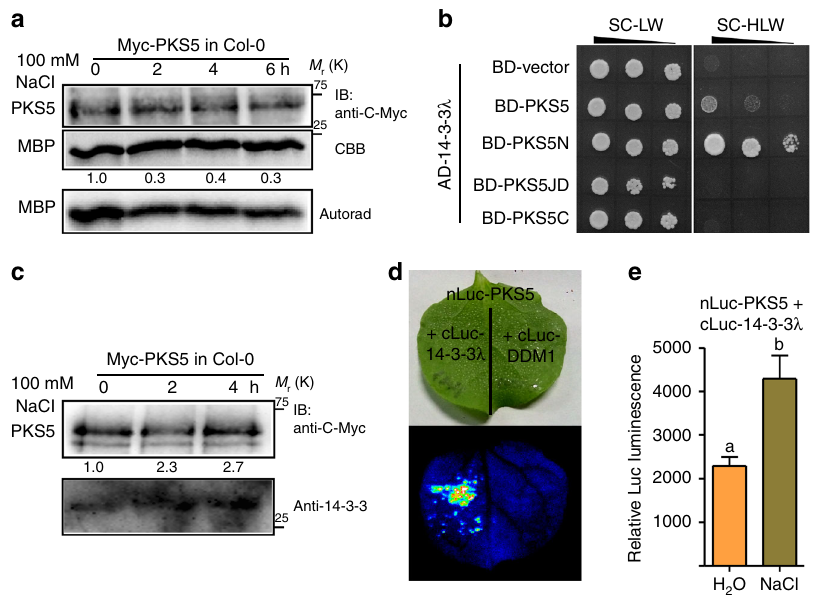
Fig. 4 Salt stress enhances the interactions between 14-3-3 proteins and PKS5. a In vitro kinase assay shows that salt stress decreases PKS5 activity. Myc- PKS5 was extracted from 10-day-old Col-0 seedlings transgenically expressing Pro35S:6×Myc-PKS5 treated with 100 mM NaCl for the indicated periods. MBP was used as the substrate. b Yeast two-hybrid assay showing that 14-3-3 λ interacts with the kinase domain of PKS5. PKS5N, kinase domain (amino acids 1 – 280); PKS5JD, junction domain (amino acids 281 – 306); PKS5C, C-terminal regulatory domain (amino acids 307 – 435). c In vivo Co- immunoprecipitation assay showing that salt stress enhances the interaction between PKS5 and 14-3-3 proteins. Myc-PKS5 was extracted from Col-0 expressing Pro35S:6×Myc-PKS5 treated with 100 mM NaCl for the indicated periods, and then analyzed by immunoblotting with anti-C-Myc and anti-14-3-3 antibodies. d PKS5 interacts with 14-3-3 λ in a Luciferase complementation assay. DDM1 was used as a negative control. e Luciferase complementation imaging assay showing that treatment with 200 mM NaCl enhances the interaction between PKS5 and 14-3-3 λ . Error bars represent SD; p ≤ 0.05, Student ’ s t -test; n = 6; signi fi cant difference is indicated by different lowercase letters. CBB Coomassie Brilliant Blue, Autorad autoradiograph, IB immunoblot. Source data of a , c , and e are provided in the Source Data fi